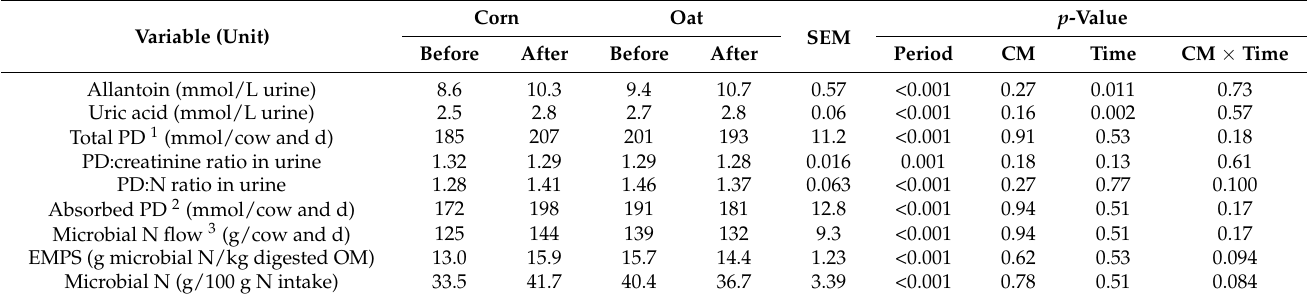
Table 5. Urinary purine derivatives (PD) excretion and duodenal microbial nitrogen (N) flow of lactating Brown Swiss cows grazing a mixed alfalfa-ryegrass sward and supplemented with a corn- or an oat-based concentrate mixture before or after grazing (least-squares means, standard errors of means (SEM); n = 18).